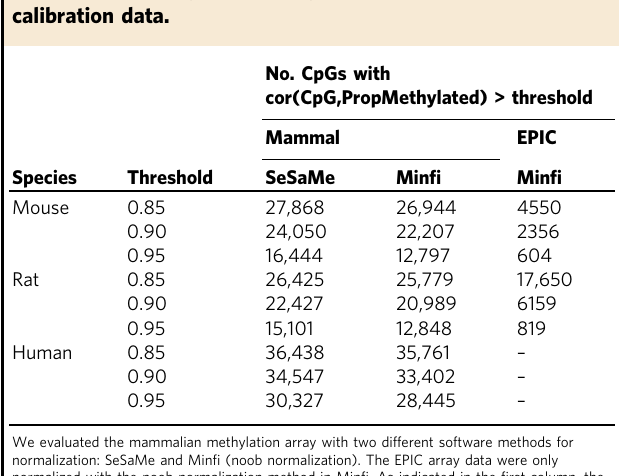
Table 1 Correlating DNA methylation levels with calibration data.